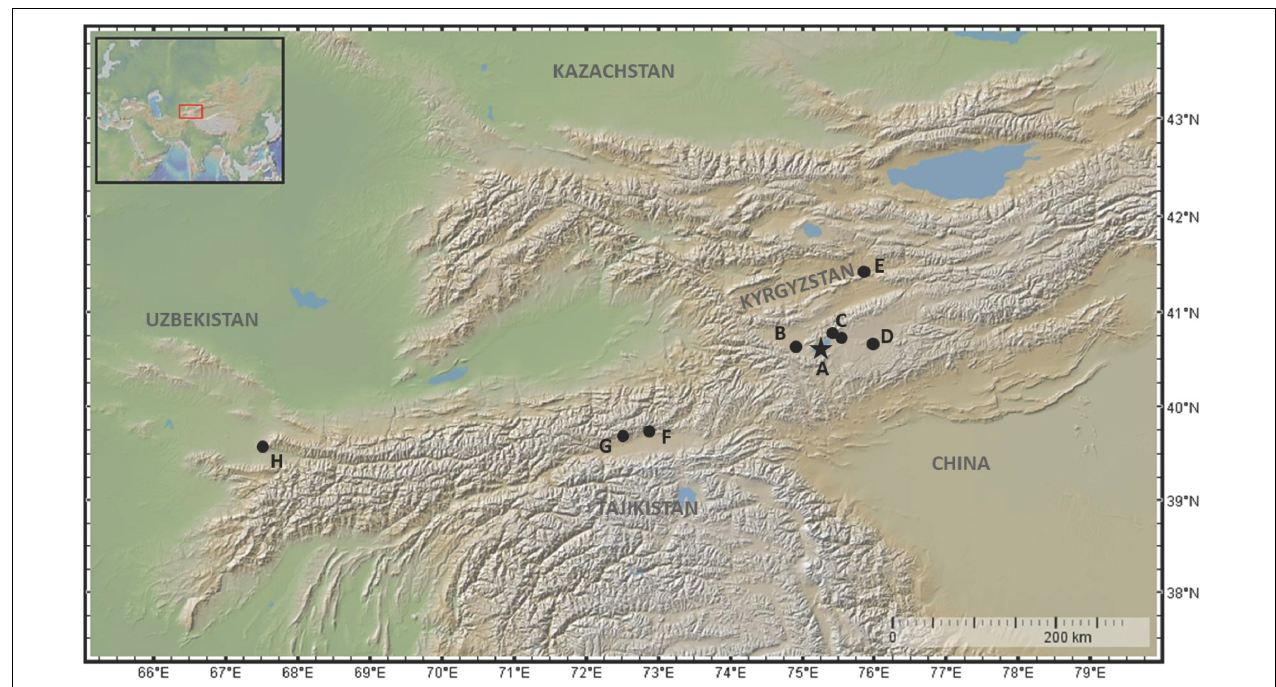
FIGURE 1 | Map of Central Asia showing the study site Lake Chatyr Kol (indicated by a black star) and other sites mentioned in this study. A = Lake Chatyr Kol; B = Grotto Semetey (Abdykanova, 2014); C = Kok-Aygyr (Ranov and Kydyrov, 1969); D = Terek-1 (Ranov, 1975); E = Aigyrzhal-2 (Motuzaite Matuzeviciute et al., 2017); F = Alay Valley (Shnaider S. et al., 2018); G = Chegirtke Cave (Taylor et al., 2018); H = Sarazm (Spengler and Willcox, 2013). Figure made with GeoMapApp (www.geomapapp.org, Ryan et al.,